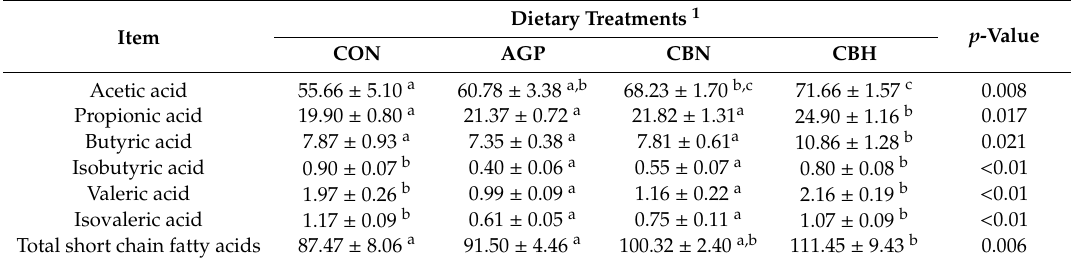
Table 4. E ff ect of dietary C. butyricum on short-chain fatty acids in colonic chyme (mean ± SE 2 , µ mol / g).